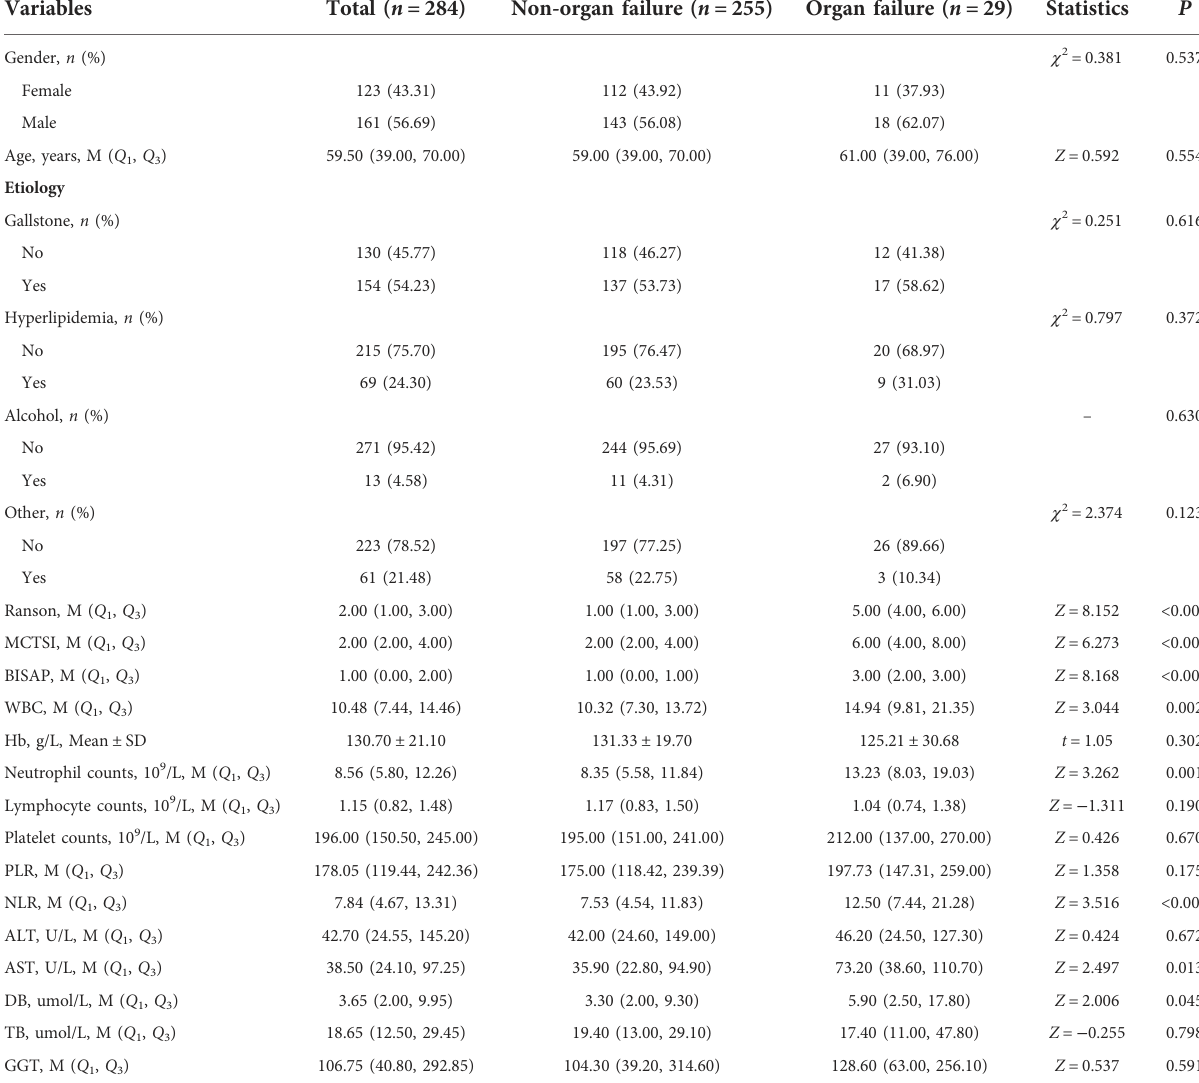
TABLE 4 Differences of population characteristics between patients with and without organ